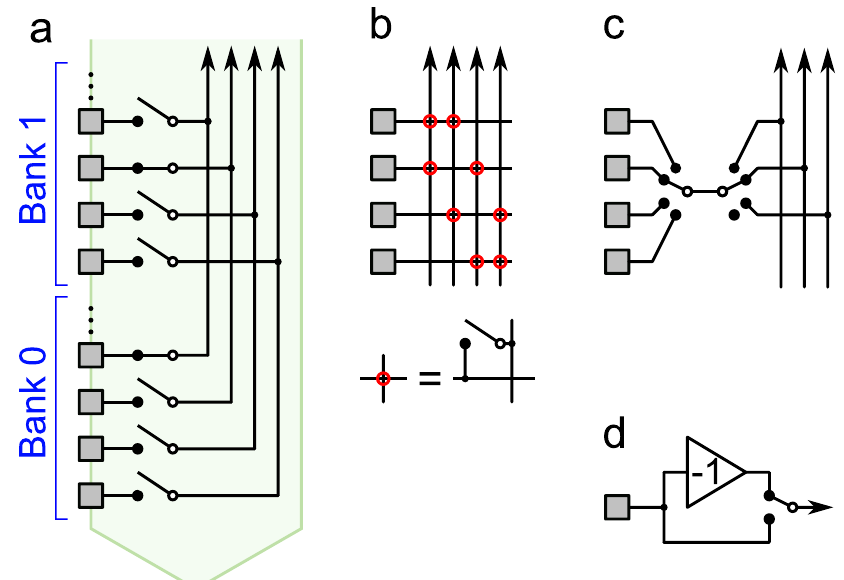
Fig. 7 Hardware schemes for fl exible connection between electrodes and wires. a In the current Neuropixels array each electrode can be connected to just one wire with a controllable switch. b Two switches per electrode would allow a choice of 2 wires, enabling many more pooling con fi gurations. c Because neighboring electrodes often carry redundant signals, one may want to choose just one from every group of 4. This switch circuit matches that choice with one of 3 (or no) wires. d An optional inverter for each electrode, controlled by a local